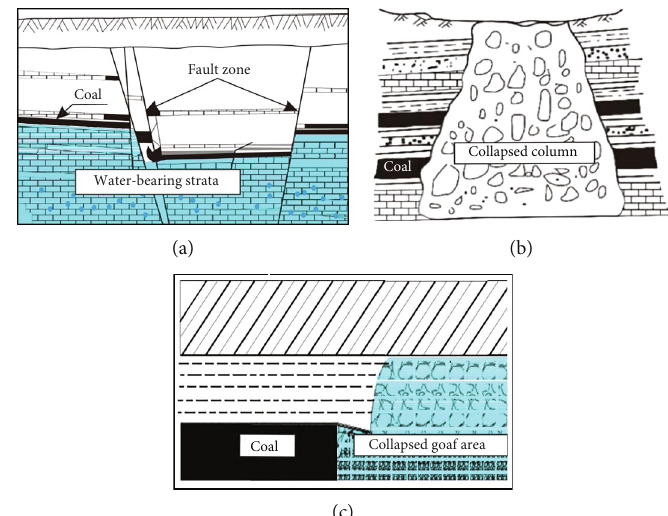
Figure 2: Geological model of water-conducting structures: (a) fault, (b) collapsed column, and (c) collapsed goaf